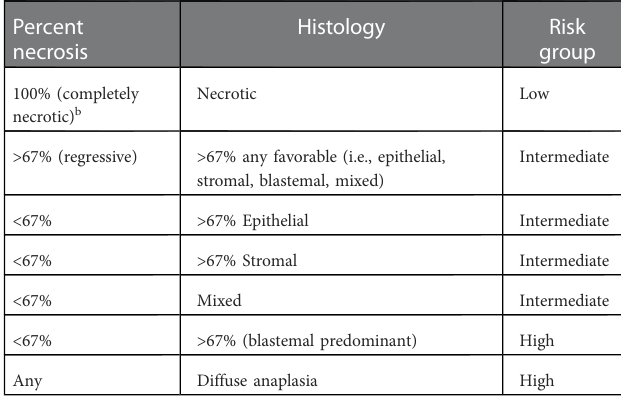
TABLE 2 Post chemotherapy histology risk group assignment according to SIOP a